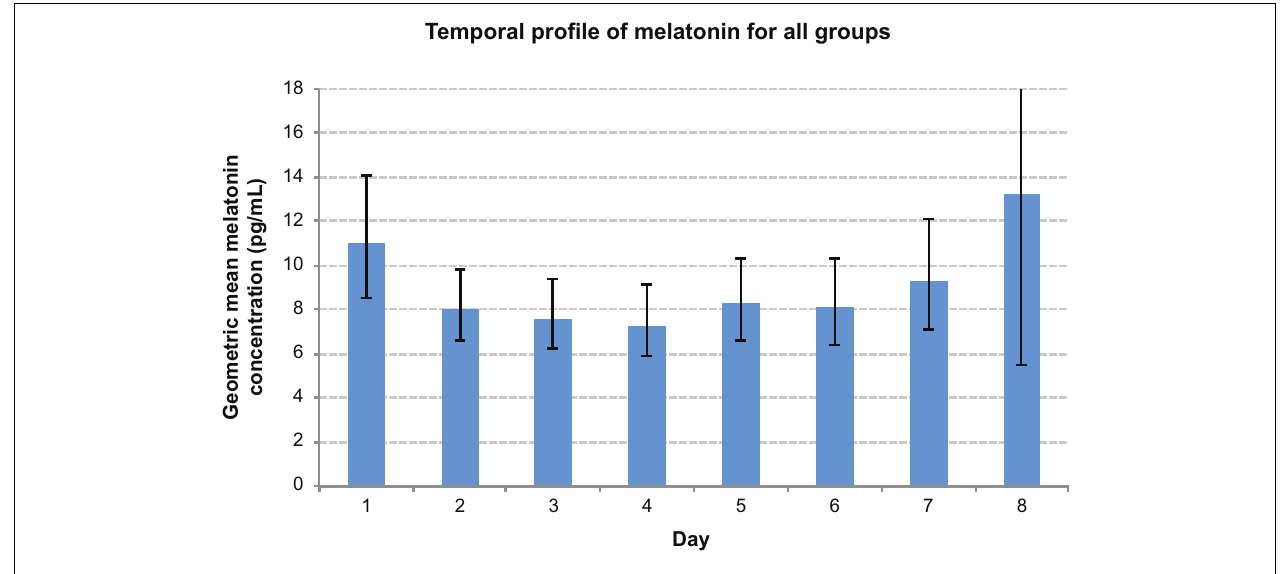
FIGURE 6 | Comparison graph of day effect . Day 1 values were significantly elevated when compared with days 2–6.